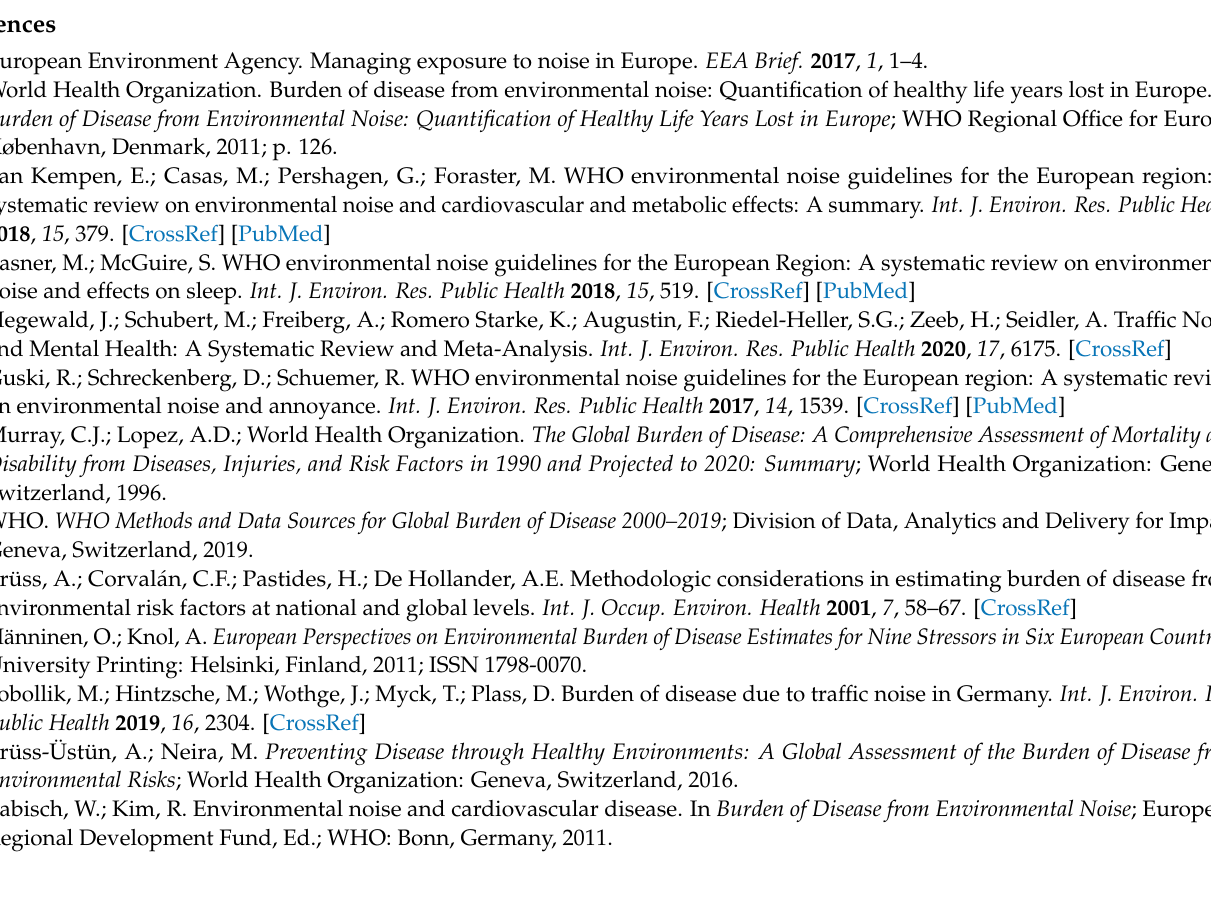
Figure A1. Maps of road-traffic noise exposure in L DEN for one location (Lauterbach, Hesse) ( a ) according to the European guidelines and ( b ) according to the “PLUS-mapping” [67].